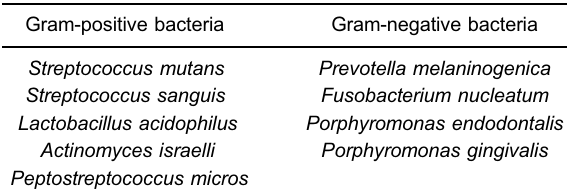
Table 1. Gram-positive and gram-negative cariogenic bacteria investigated in this study. Gram-positive bacteria